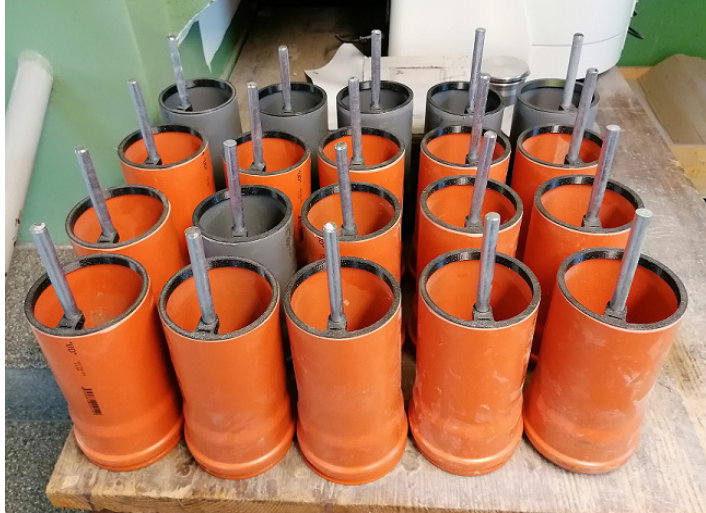
Figure 2. Detailed view of test fixtures for bond strength tests before filling with cement paste. The bond strength between the plain bars and a cement paste is determined by meas- uring the bond stress slip (LVDT sensor—Micro-Epsilon Messtechnik GmbH, Ortenburg, Germany) on the unloaded end of plain bars by loading device TIRA test 100 kN (viz Figure 3). The test was controlled by displacement of the unloaded end of a reinforcing bar. A constant loading rate of 0.005 mm s − 1 was applied. The setup of the pull-out test is displayed in Figure 3. The test was terminated after reaching a slip of 1.6 mm.